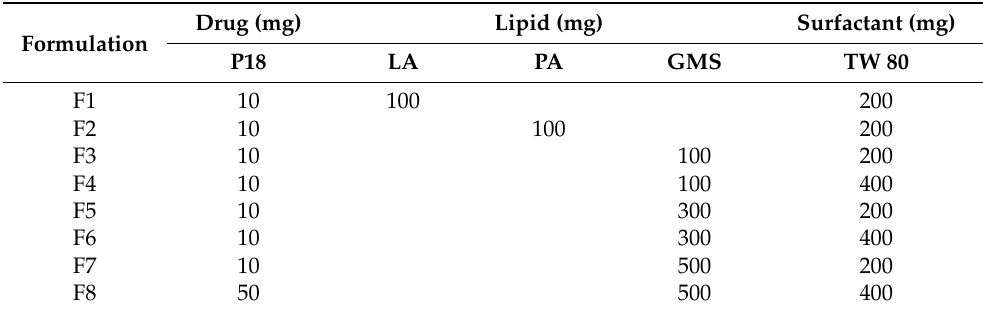
Table 1. Compositions of P18-loaded